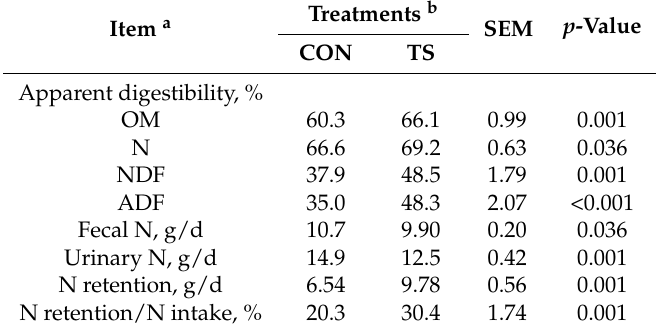
Table 3. Effects of tea saponin (TS) supplementation on the apparent digestibility of nutrients and nitrogen balance in ewes. Treatments b SEM p -Value Item a CON TS Apparent digestibility,